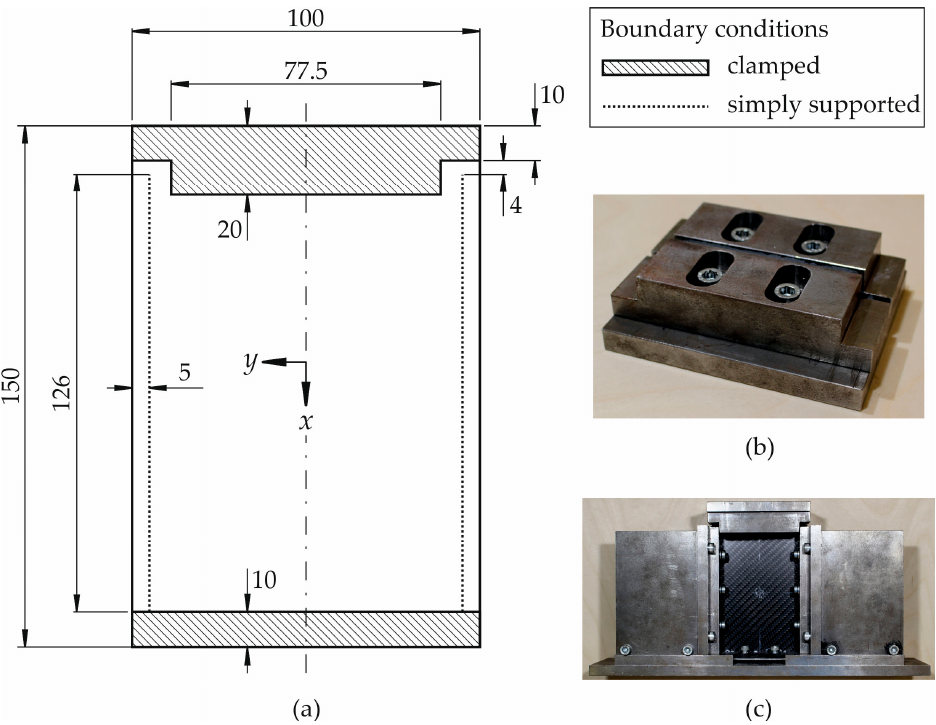
Figure 2. ( a ) Schematic fixture of composite plate (nominal dimension 100 mm × 150 mm) within modified CAI test device, ( b ) top part of modified CAI test device and ( c ) schematic fixture after modification with integrated sample.